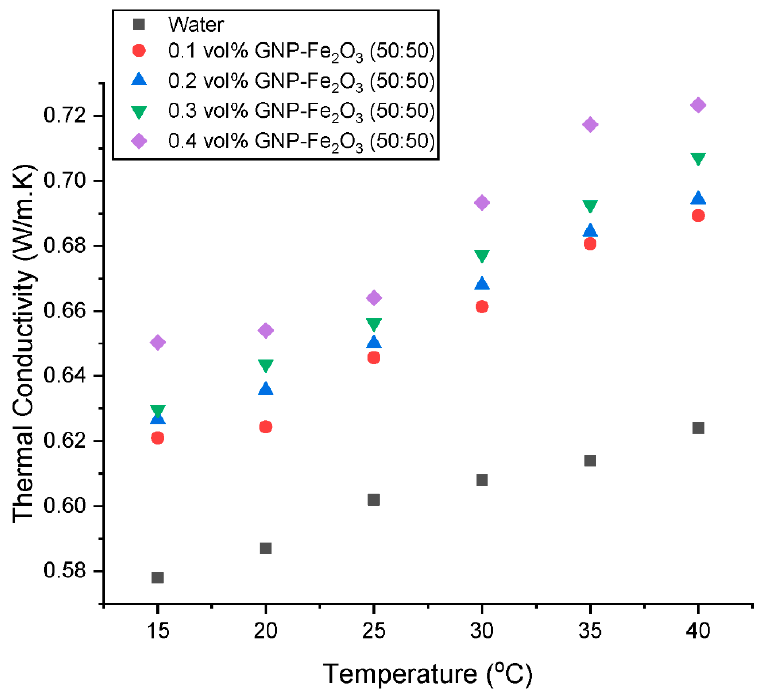
Figure 10. Influence of temperature on the thermal conductivity of the hybrid nanofluids at various concentrations.